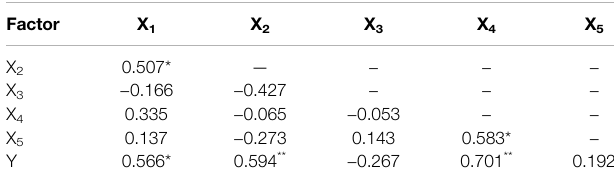
TABLE 2| The correlation among yield components and other related characters.